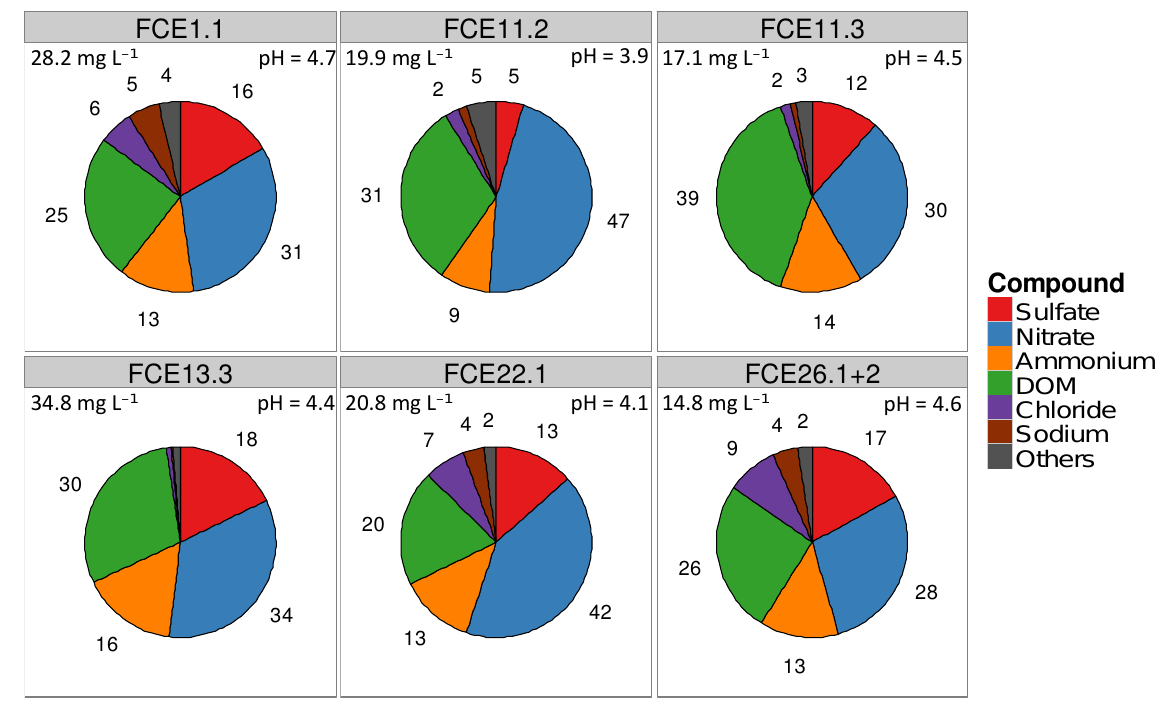
Figure 1. Volume-weighted mean composition of bulk cloud water during main events. Numbers represent percentage from total solute concentration (in mgL − 1 ) . Trace solutes calcium, magnesium, potassium, H 2 O 2 (aq), and S(IV) are summarised as “others”. DOM is calculated as DOC × 1.8. Total solute concentrations and pH values derived from VWM H + concentrations are indicated in the upper left and right panel corners respectively.